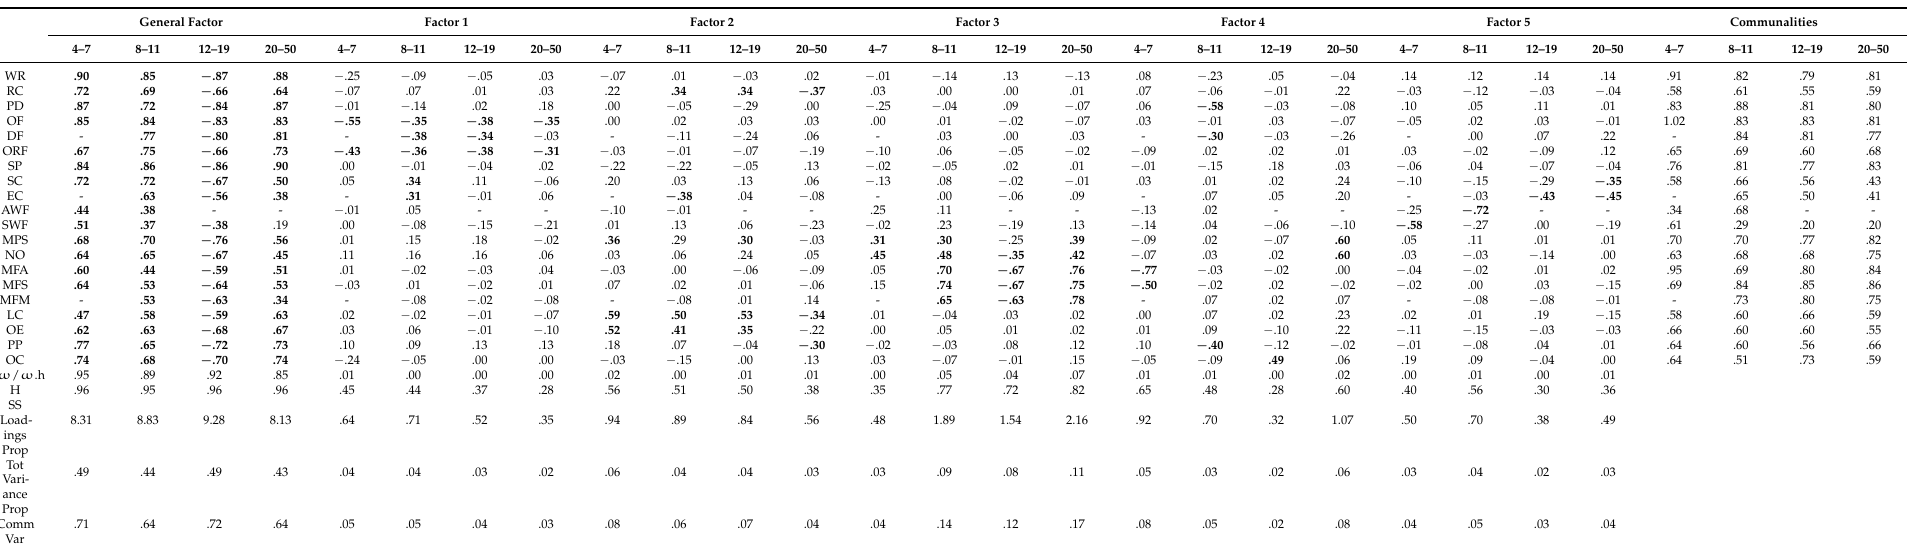
Table A3. Bifactor Solution with Five Specific Factors Across Age